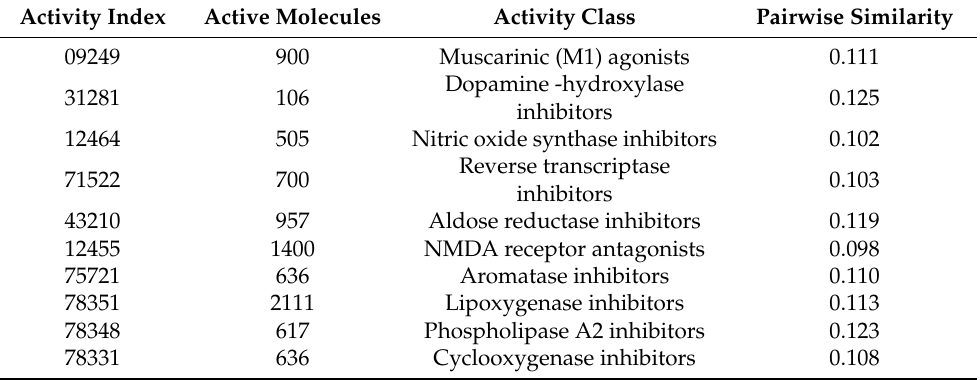
Table 3. The MDDR-DS3 structure activity classes.